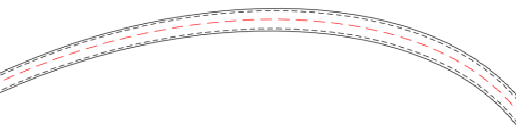
Figure 10. Arc straight track scene diagram.